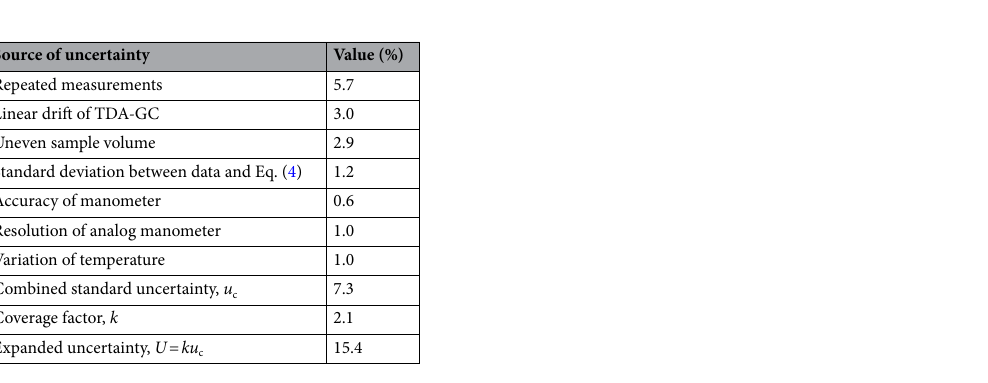
Table 2. Summary of uncertainty source and expanded uncertainty for permeation parameters of